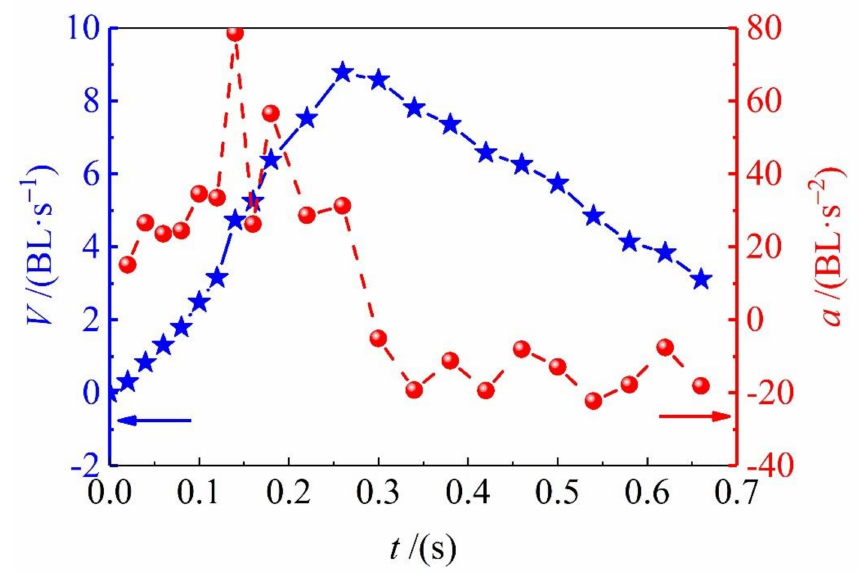
Figure 4. Sprint speed and acceleration of juvenile Solen strictus